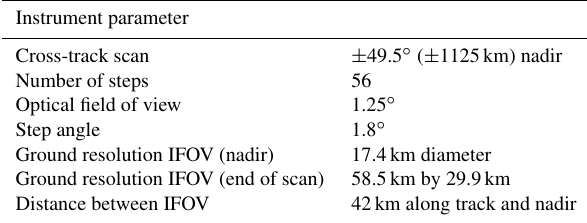
Table 2. HIRS/2 instrument